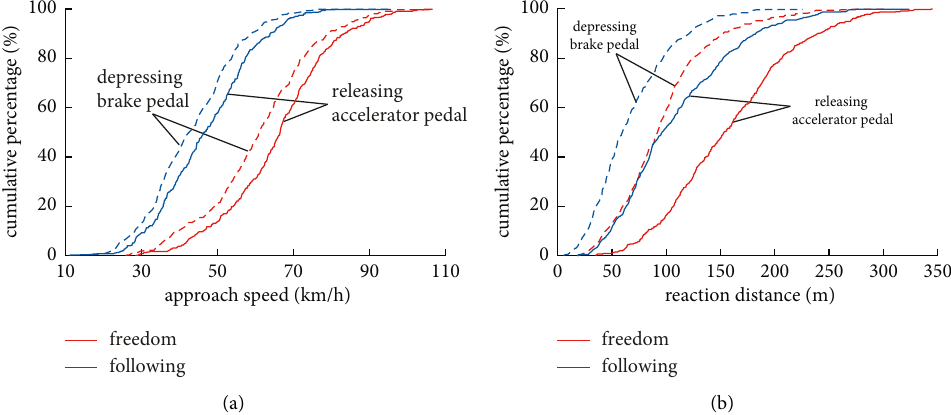
Figure 6: Approach speed and reaction distance by traffic